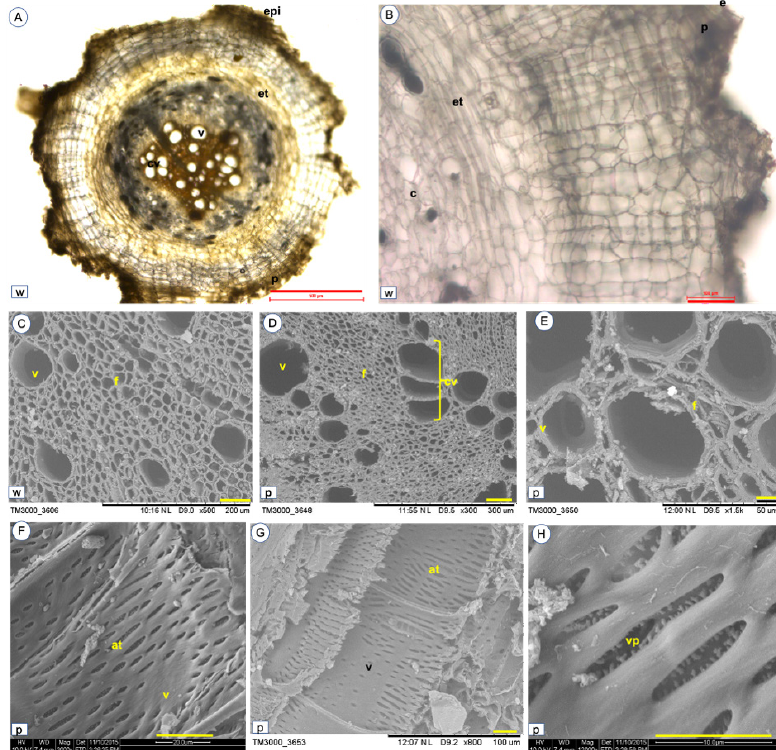
Figure 4 : Root anatomy of the two flower colour types of Calotropis gigantea as seen by LM (A and B) and SEM (C - H). (A) cross- section of root stained with TBO. (B) cellular arrangement of ground tissue and endodermal layer. (C) xylem tissue showing semi- ring-porous vessels (D) xylem tissue showing clusters of 2–3 round or irregular vessel elements (E) barrel-shaped vessels. (F) alternate thickenings. (G) slit-like apertures of vessel element. (H) vessels and fibers. Sub-figure letters: p - purple. w- white. All images are of the purple form other than A, B, and C which was from the white form. Abbreviations used: at: alternate thickenings. co: cortex. cv: a cluster of vessels. e: epidermis. et: endodermal tissues. f: fibers. p: phellem. v: vascular tissues. vp: vascular projections. Scale bar 10